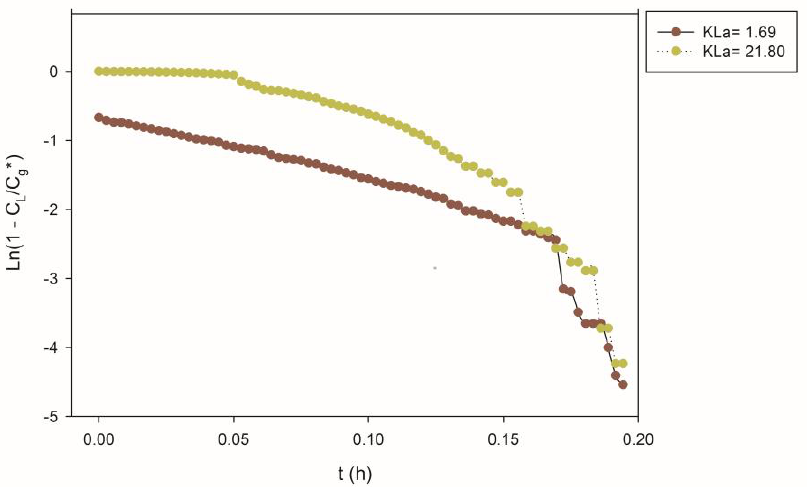
Figure 1. k LaCO2 as a time function. The analyzed variables were FeSO 4 · 7H 2 O (2, 4, 8, and 14 q/L w / v ), silicone oil (0%, 5%, and 10% v / v ), and mining waste (30%, 40%, and 50% w / v ). Comparison between the highest value of k LaCO2 (21.8 h − 1 ) and the lowest value of k LaCO2 (1.69 h −1 ). C g* is the concentration of carbon dioxide saturation over time.